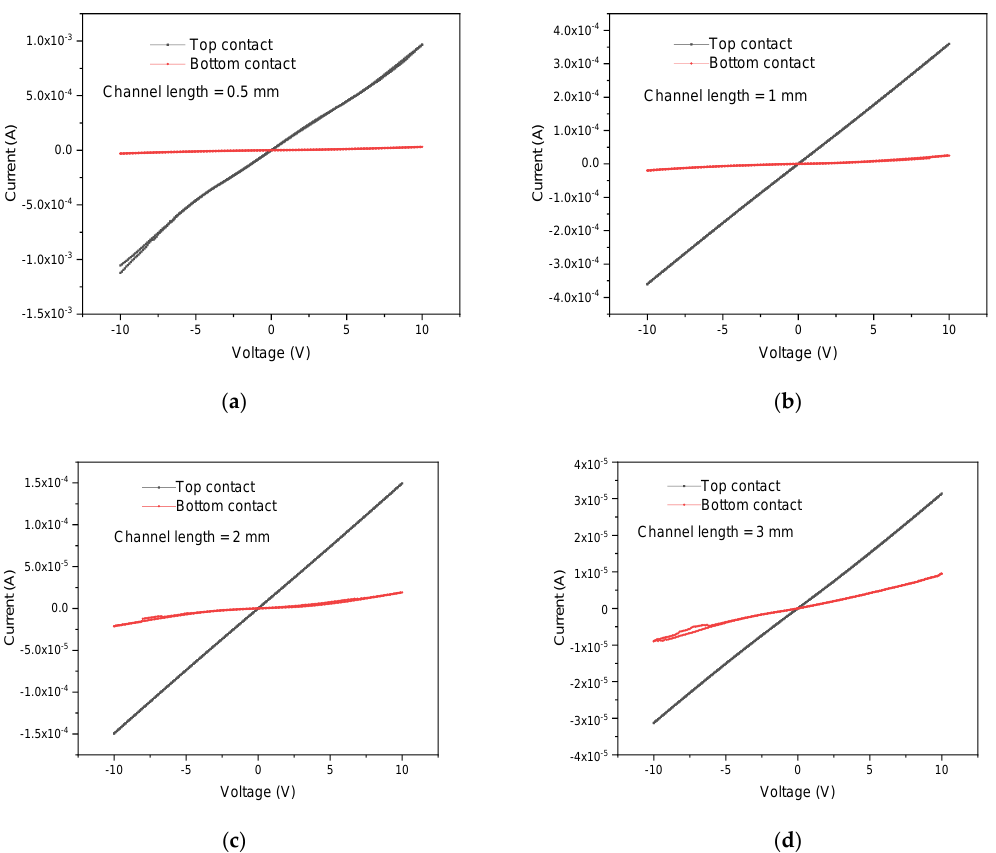
Figure 4. IV results for bottom and top contacts with DIPS SWCNTs at different channel lengths; ( a ) 0.5 mm; ( b ) 1 mm; ( c ) 2 mm; ( d ) 3 mm.